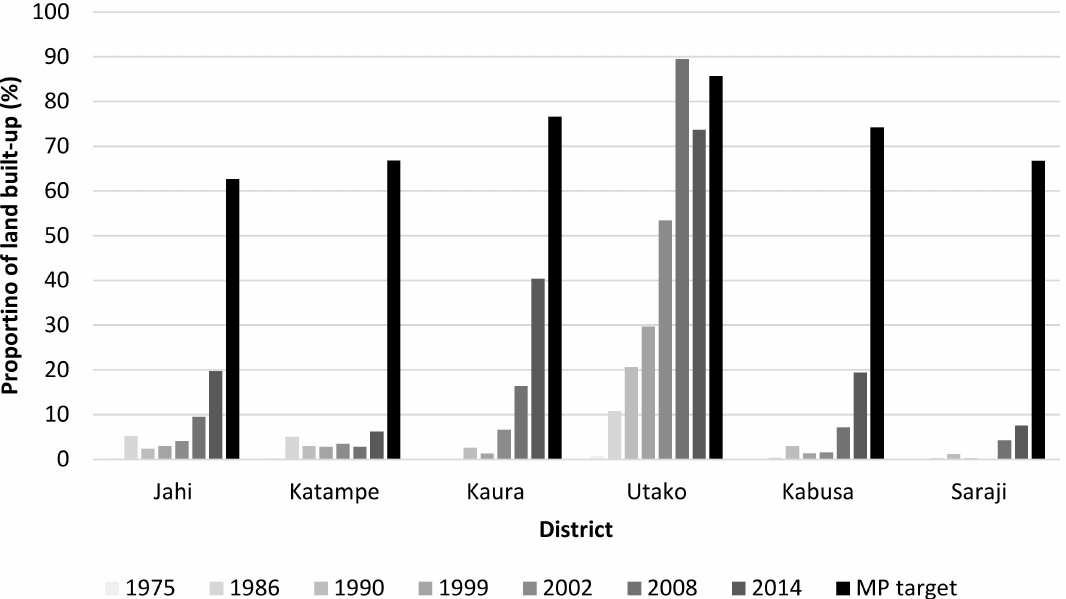
Figure 6. Areal coverage of built-up land in individual districts over time compared to the target coverage specified originally in the Master Plan (MP). (Jahi, Katampe, Kaura and Utako in MP development Phase 2; Kabusa and Saraji in Phase